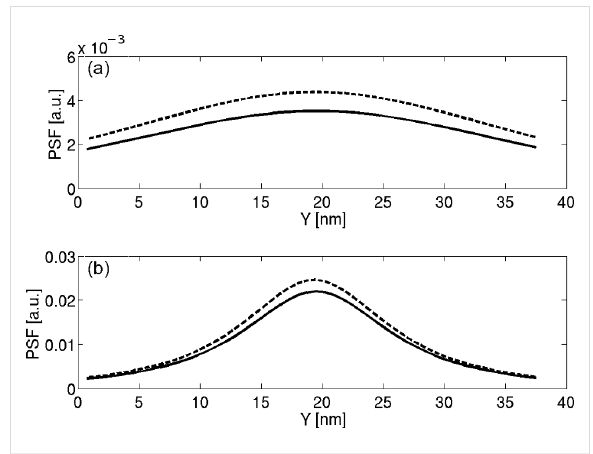
Figure 8: Second harmonic weighting influence on the PSF. Dashed lines: PSF calculated with the second harmonic displacement, using virtual work equilibrium. Solid lines: PSF calculated for a rigid cantilever. (a) Probe–sample distance d = 11.4 nm; (b) averaged PSF for amplitude of 20 nm with a minimum distance of 1 nm. For both cases the cantilever parameters were W = 40 μ m, β =